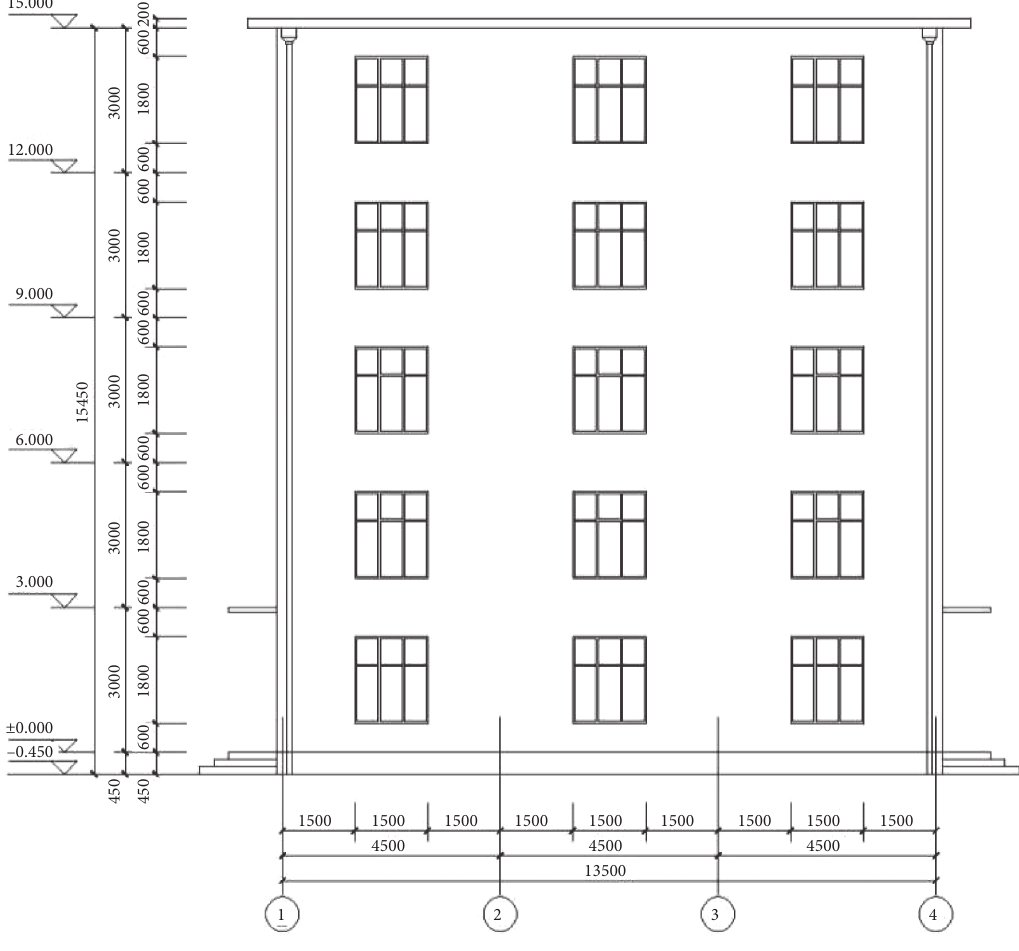
Figure 4: Elevation view of the building. Table 1: Material properties.